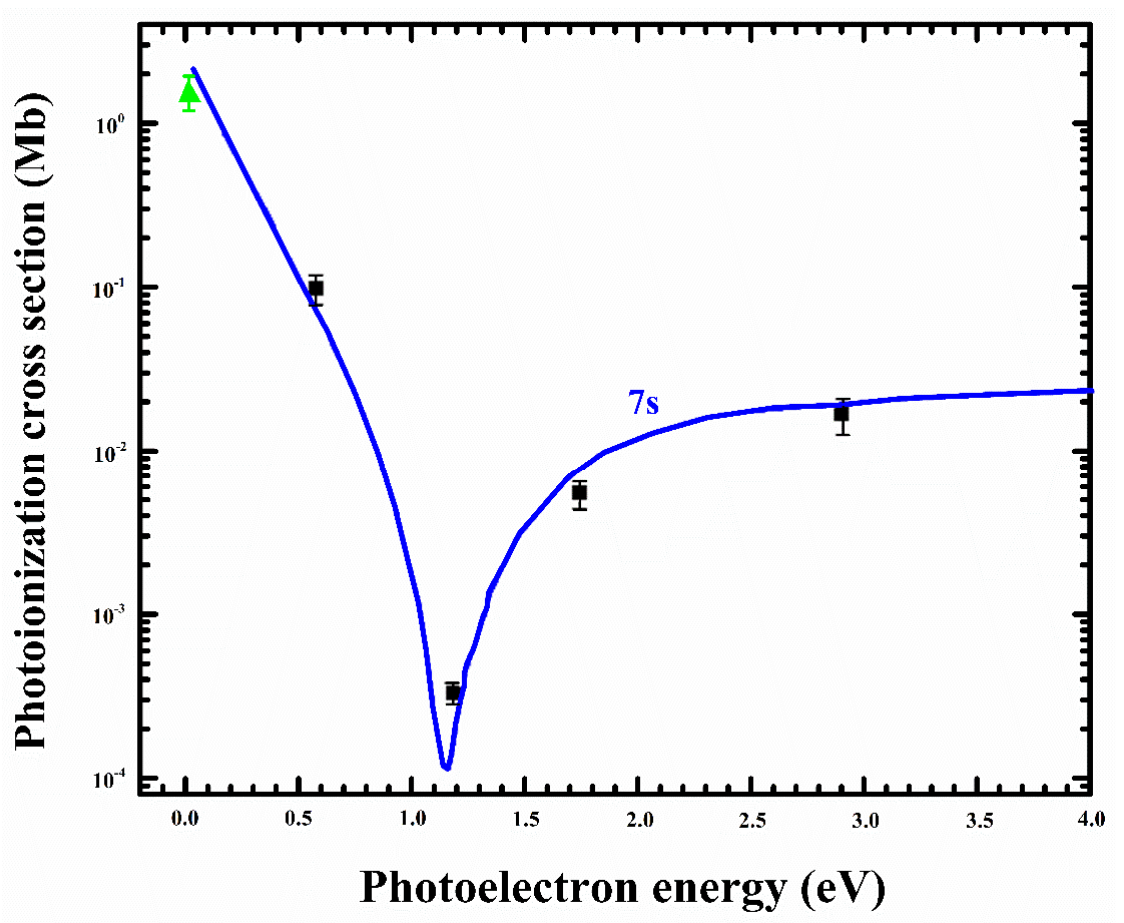
Figure 5. The photoionization cross-section was measured from the 7s excited state of potassium using five ionizing laser wavelengths at and above the first ionization threshold. The continuous curve is the theoretical results of Zatsarinny and Tayal [66], which follow the experimental values.